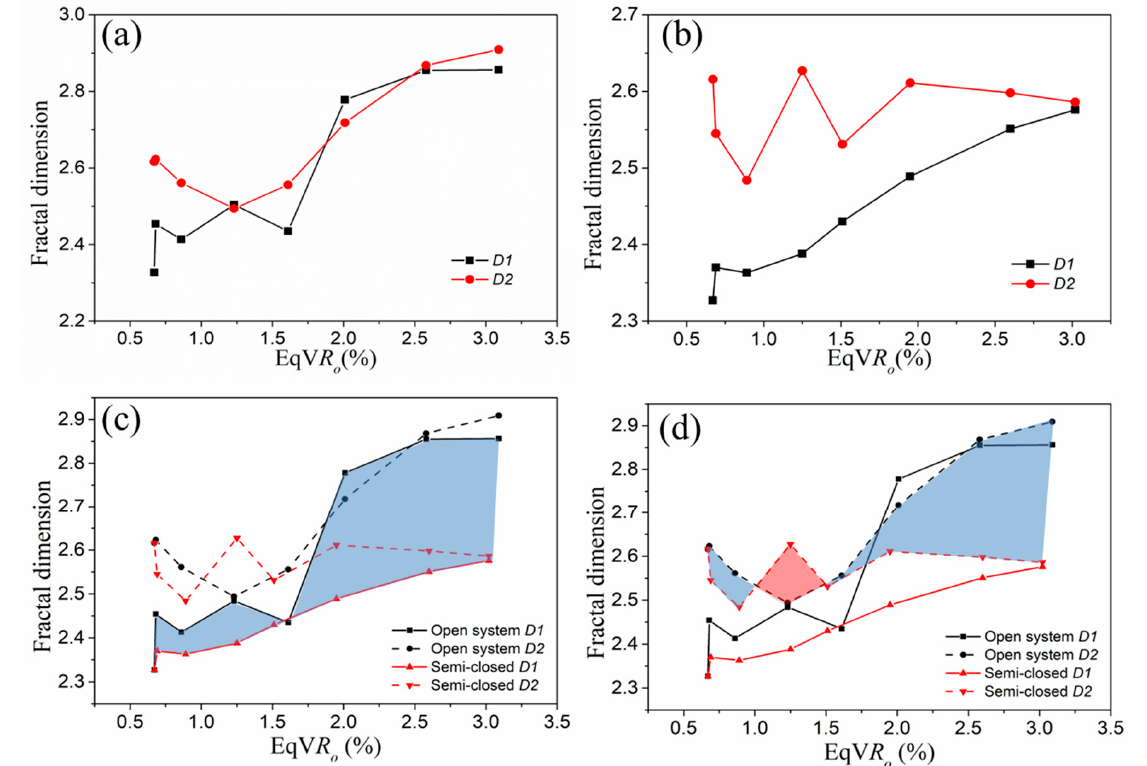
Figure 13. Relationships between fractal dimension and R o based on ( a ) the open system and ( b ) semi-closed system pyrolysis experiments; ( c ) pore surface fractal dimension variation between the open and semi-closed system pyrolysis experiments during shale thermal evolution; ( d ) pore structure fractal dimension variation between the open and semi-closed system pyrolysis experiments during shale thermal evolution. Note: D1 is the pore surface fractal dimension, and D2 is the pore structure fractal dimension. Data of semi-closed pyrolysis are cited from Fang et al. [21].